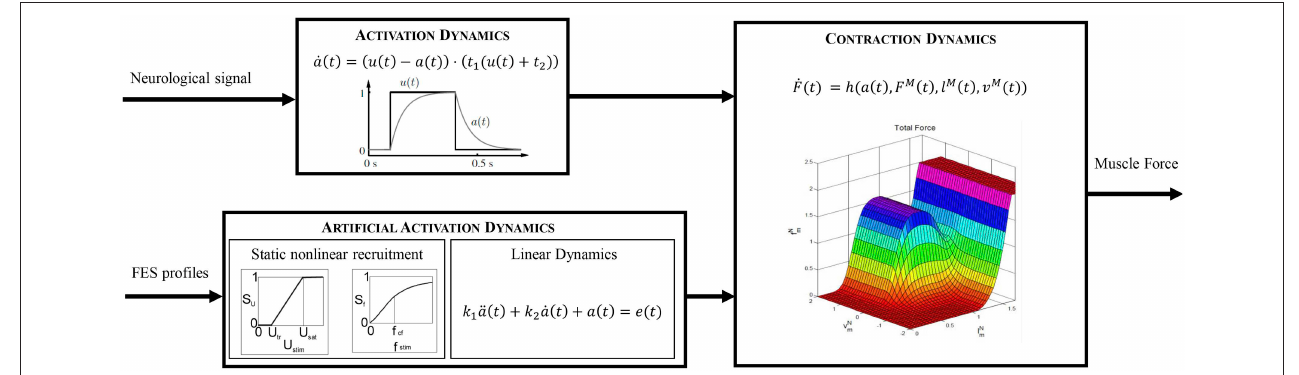
FIGURE 2 | Comparison of the different dynamics that lead to muscle force